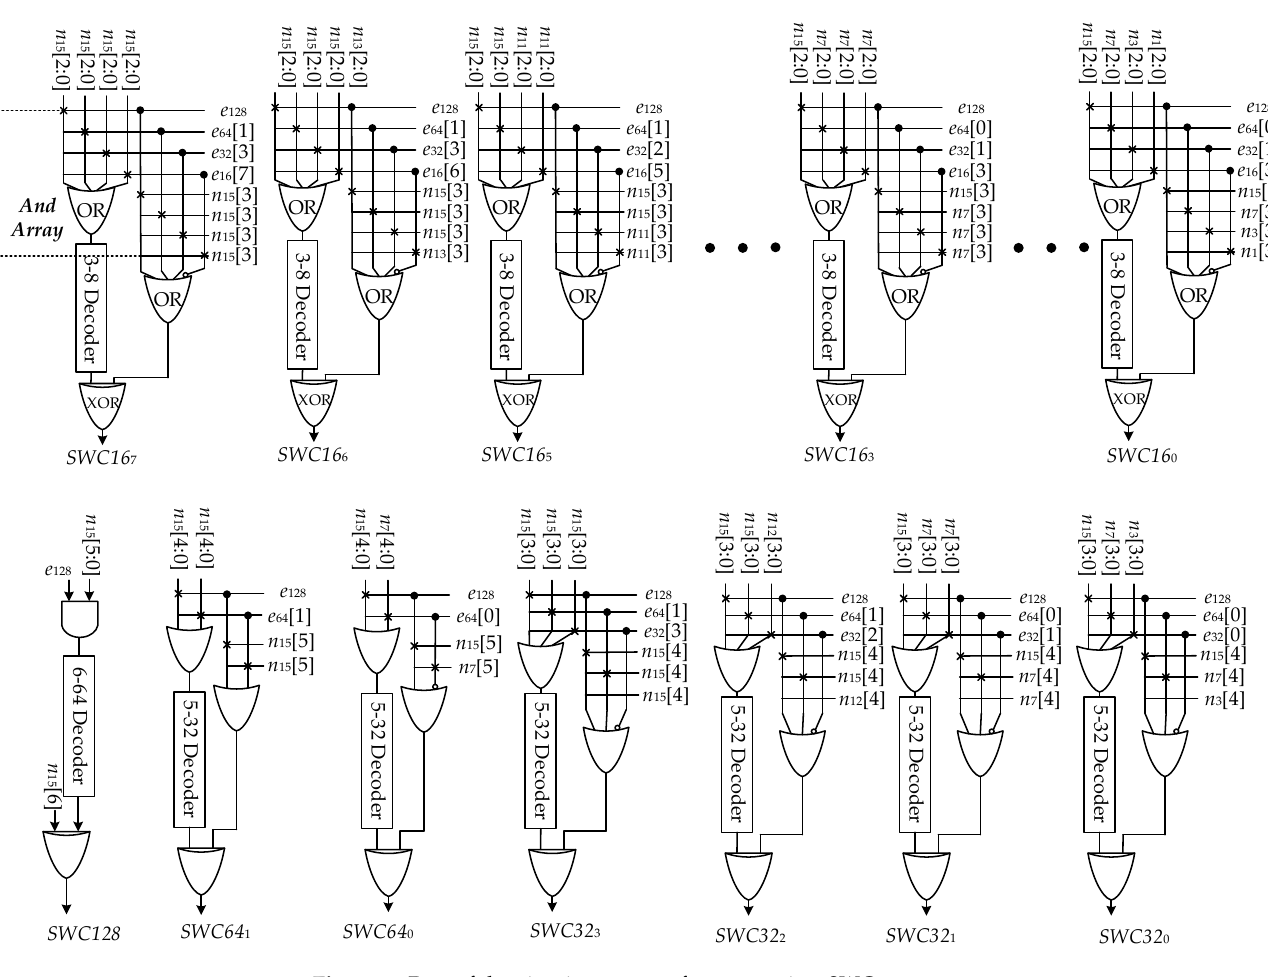
Figure 9. Part of the circuit structure for generating SWC .